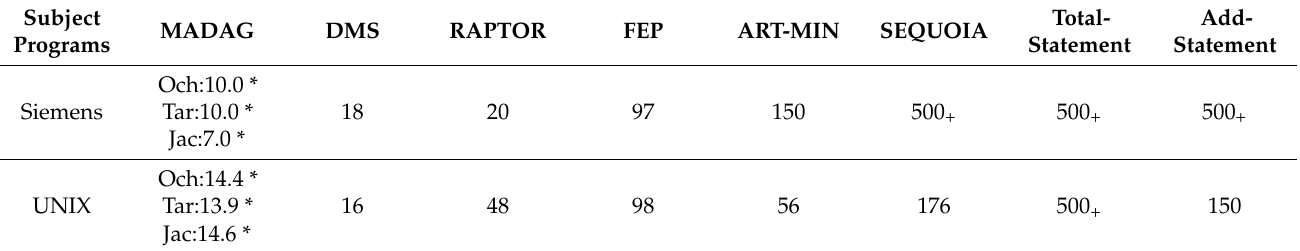
Table 5. Needed the number of test cases to SBFL techniques.